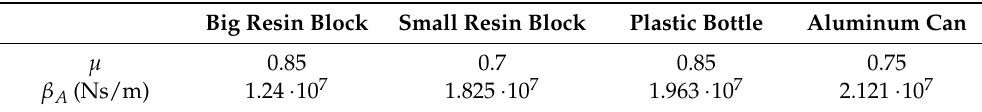
Table 2. Friction parameters estimated for the manipulated